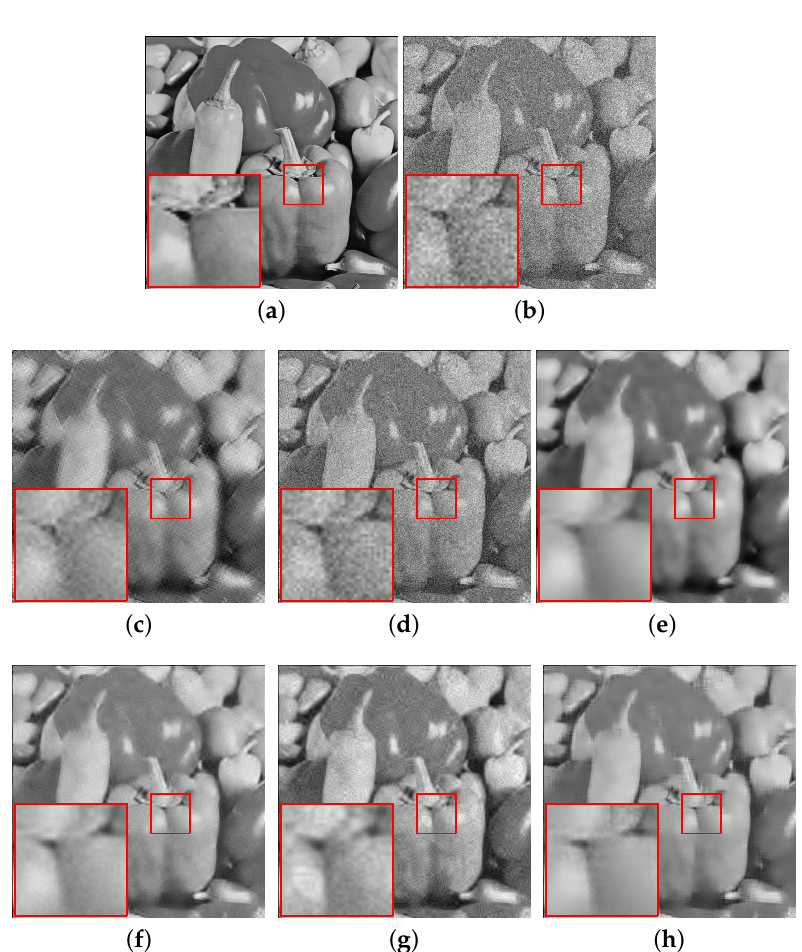
Figure 5. Comparison of the denoising results (PSNR/SSIM) of all the algorithms on the standard peppers image with σ = 35, where s = 10. ( a ) Original image; ( b ) noise image ( σ = 35); ( c ) SG-HT (21.65/0.5514); ( d ) OMP (20.48/0.3529); ( e ) GraSP (23.91/0.7546); ( f ) SVRGHT (25.88/0.7390); ( g ) LSSG-HT (25.12/0.7023); ( h ) SRGSP